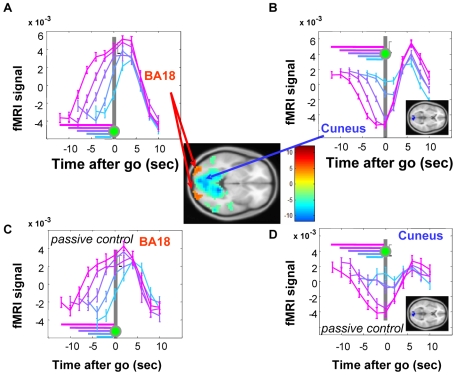
Climbing and sinking fMRI signals during the readiness period.Center inset: BA18 (peak coordinates: 28 −92 −8) are the only regions that show a climbing signal during the readiness period at p<0.001. More broadly distributed areas, most significantly in cuneus (peak coordinates: −8 −92 0) show a sinking signal at p<0.001. Color bar indicates t-value with degree of freedom 19. (A) Time series of the fMRI signal in BA18 around the go signal. (B) fMRI signal in cuneus (inset) showing sinking activity. This region is a subset of the regions shown in the center inset with a more stringent threshold of p<10−8. The dynamics of the sinking signal appear to mirror the climbing signal, suggesting the possibility that the sinking signal results from resource sharing (draining) with nearby climbing areas; however, the differential sizes of these regions (center inset) calls such a hypothesis into question. (C) fMRI signal in BA18 in the passive control experiment in which the visual stimuli are identical to the first experiment (Figure 1A) but no button press is required. Here a similar climbing signal is evident, indicating that the climbing activity in BA18 is not due to motor preparation. (D) fMRI signal in the cuneus in the passive control condition, showing that the sinking signal, like the climbing signal, is independent of motor preparation. Error bars SEM.